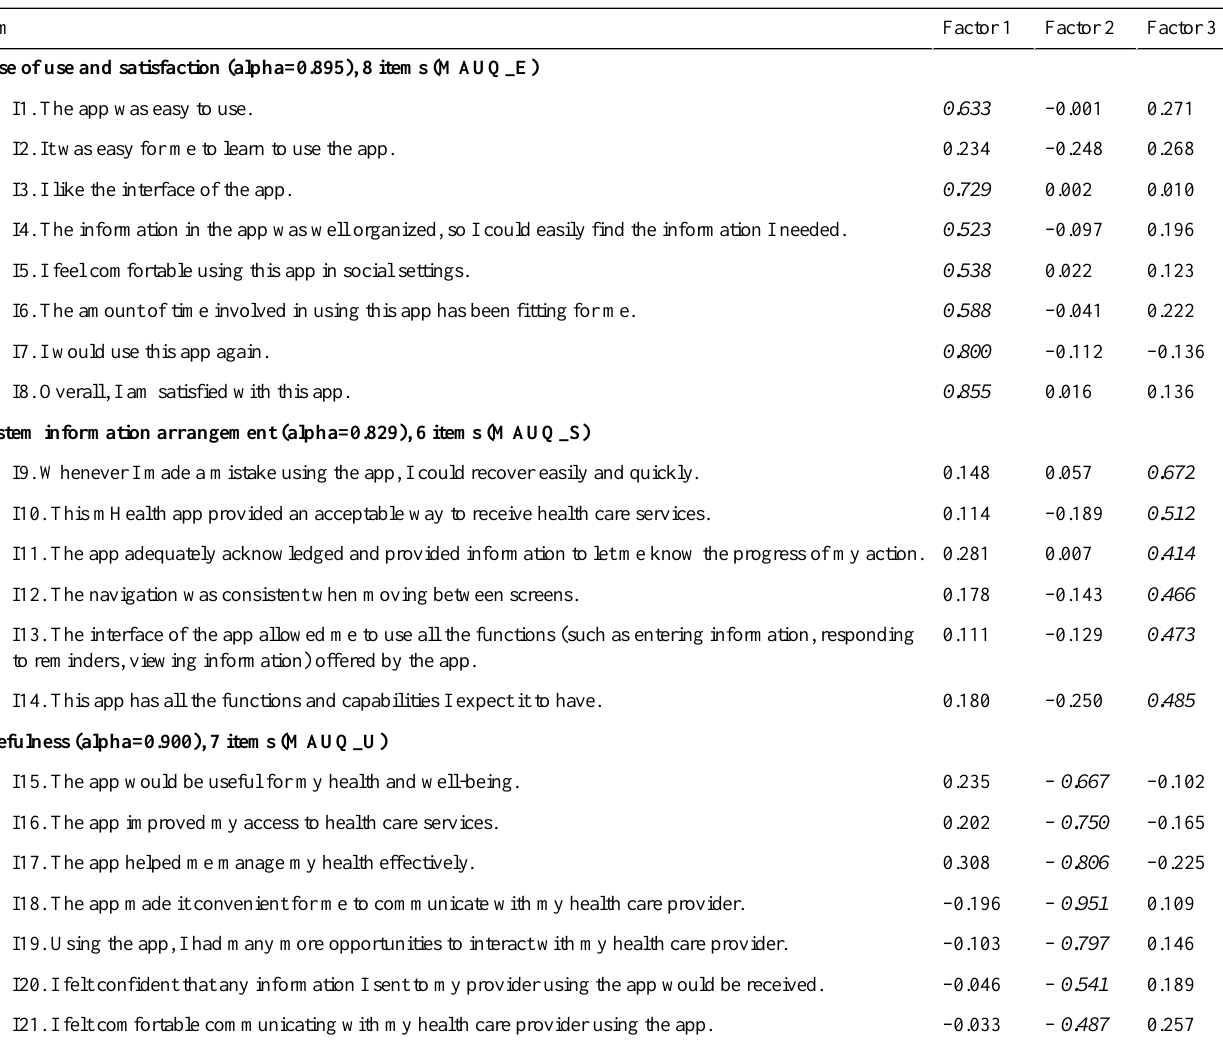
Factor 3Factor 2Factor 1Item